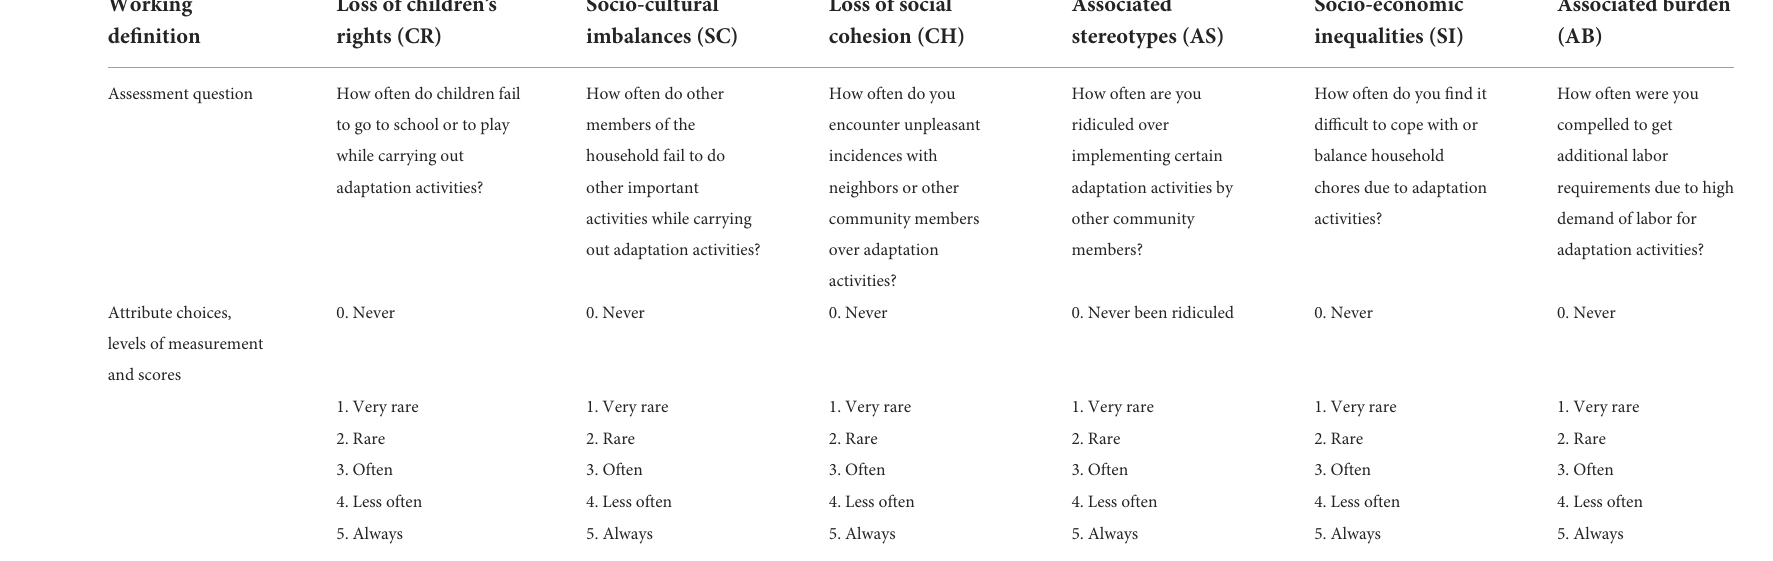
TABLE 7 Evaluation tool for estimating post-adaptation